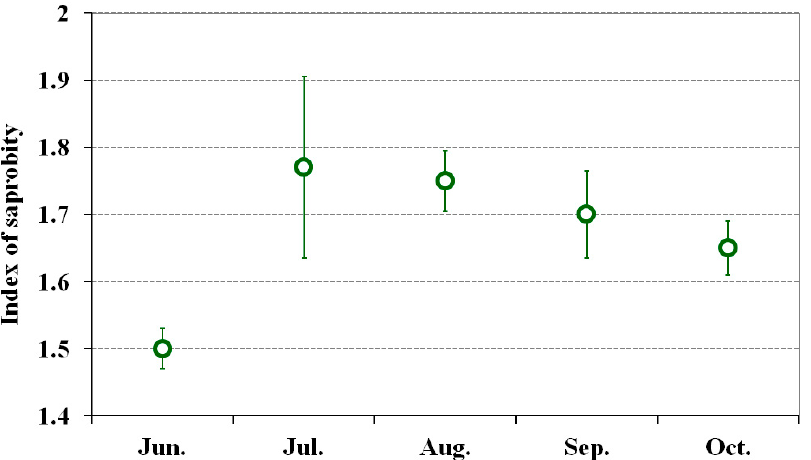
Figure 7. Changes in the saprobity index (mean value and range of values) in the littoral zone of Lake Baikal near the area of Bolshiye Koty settlement.